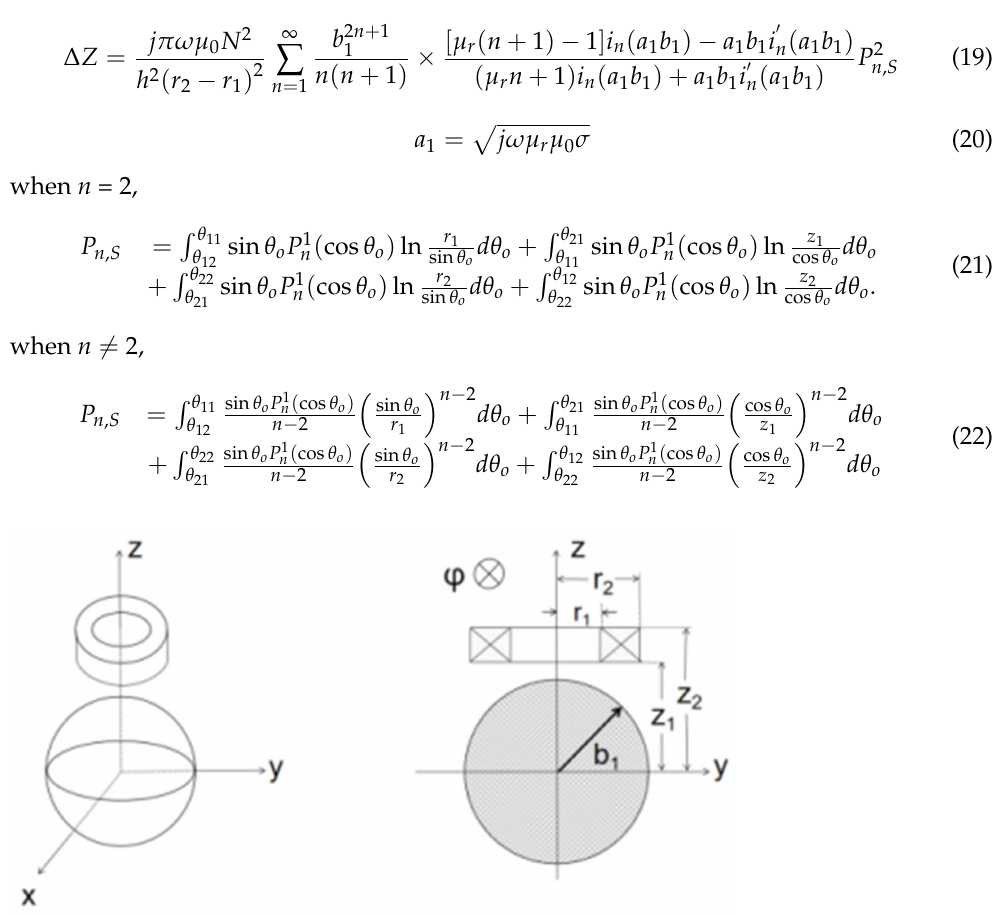
Figure 4. Full-view and cut-view of the spherical metal model. b 1 is the radius of the spherical metal, θ ij = arctan modified spherical Bessel functions and i (cid:48)